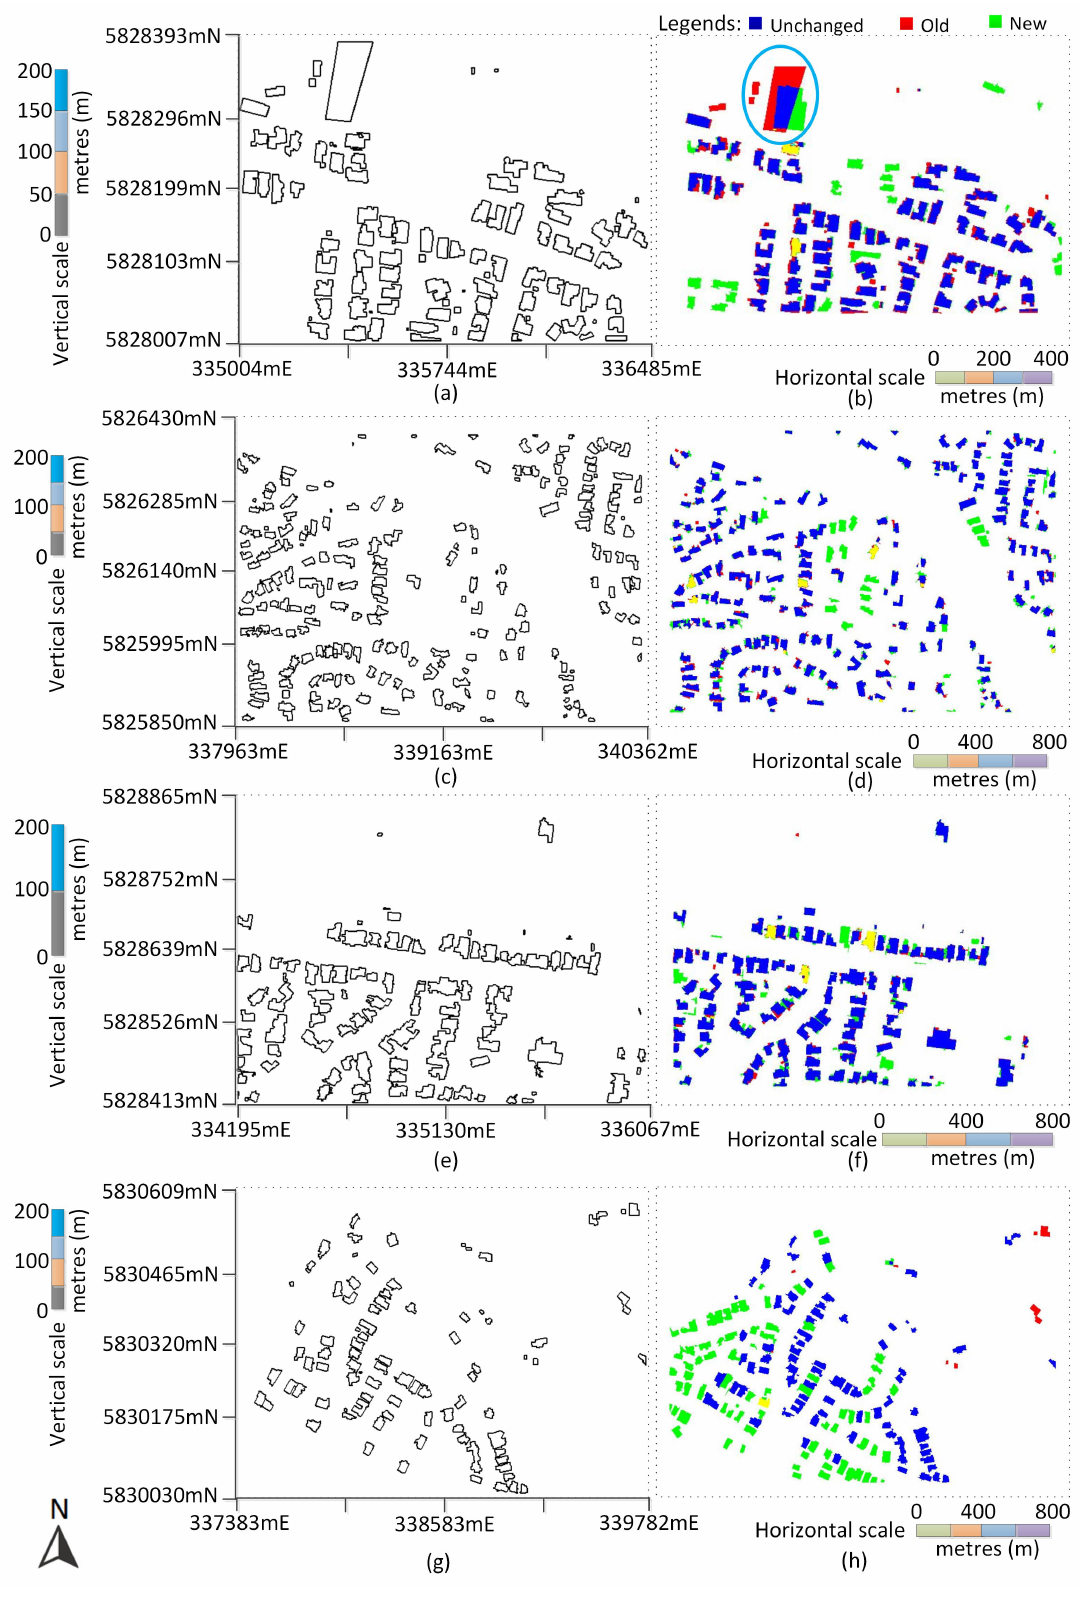
Figure 8. Left column: generated building map from 2007 datasets. Right column: automatic building detection results from 2012 datasets. ( a , b ) Scene 1, ( c , d ) Scene 2, ( e , f ) Scene 3, and ( g , h ) Scene 4. The coordinates and scales shown in ( a ), ( c ), ( e ) and ( g ) are applicable to ( b ), ( d ), ( f ) and ( h ),